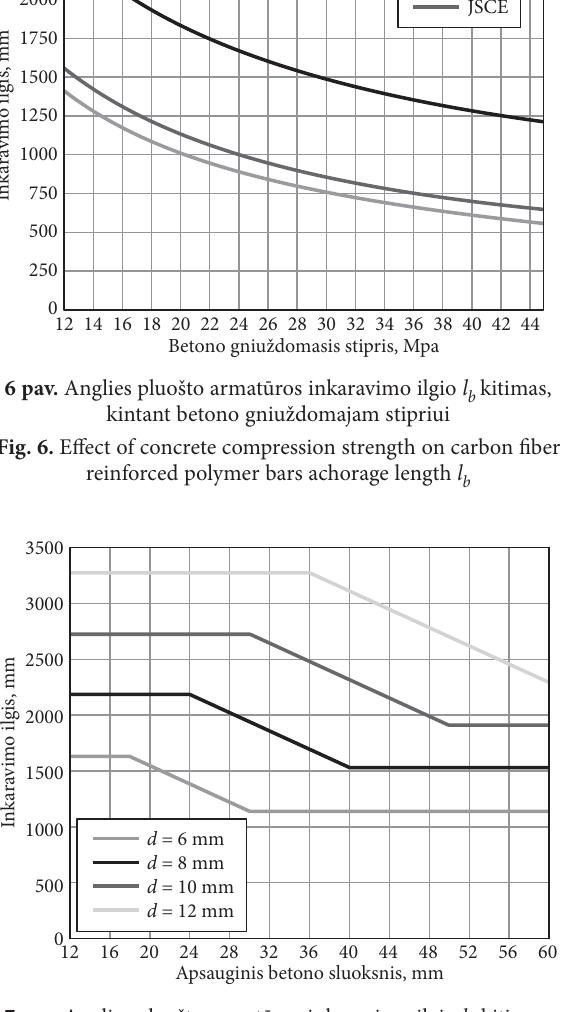
Fig. 7. Eff ect of concrete cover on anchorage length of carbon fi ber reinforced polymer (CFRP)